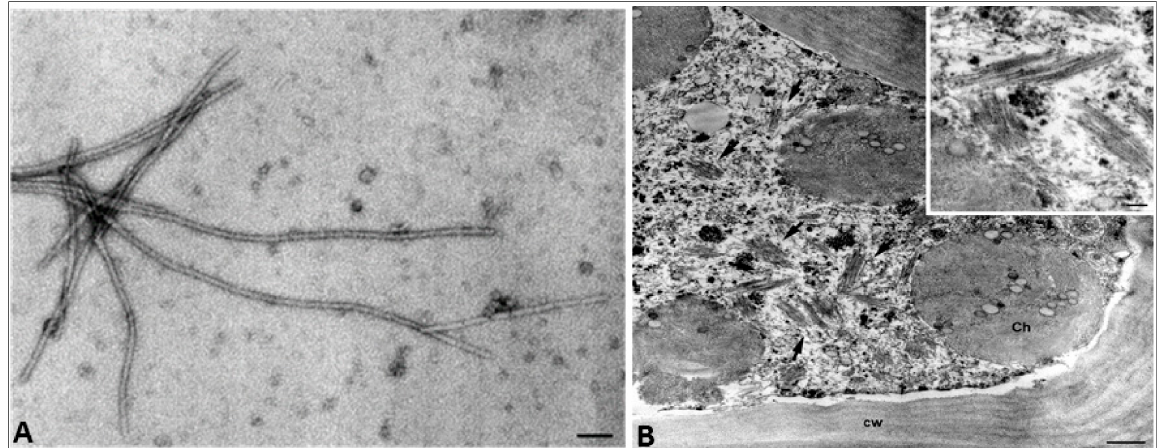
Figure 3. ( A ) : Negatively stained virus particles in leaf dip preparation from symptomatic eggplant. Bars = 100 nm; ( B ) Ultrastructural aspects of infected eggplant mesophyll cells showing virus aggregates (black arrows). (Ch) Chloroplast; (cw) cell wall. Inset shows enlargement of virus aggregates. Bar = 500 nm, inset 100 nm.